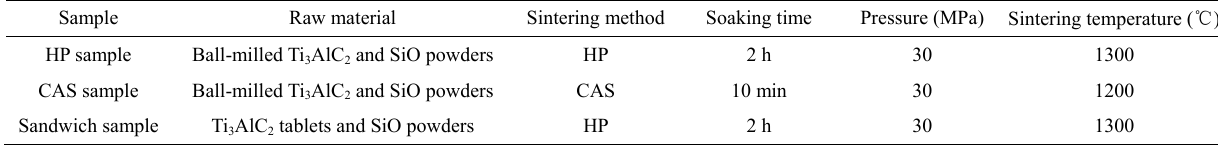
Table 2 Parameters used for the sintered